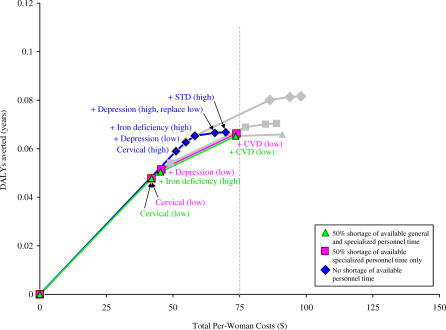
Packages of Interventions under a Lifetime Budget of $75 per Woman in AFR-D,EEach curve shows the order in which interventions are added (or substituted) when the budget is set at $75 per woman under the different scenarios of personnel time constraints: no personnel time constraints (blue), 50% constraint on specialized personnel time only (pink), and 50% constraint on both general and specialized personnel time (green). Curves in gray represent data from alternative lifetime budget set at $100 per woman (Figure 3). The dotted line represents the budget constraint.